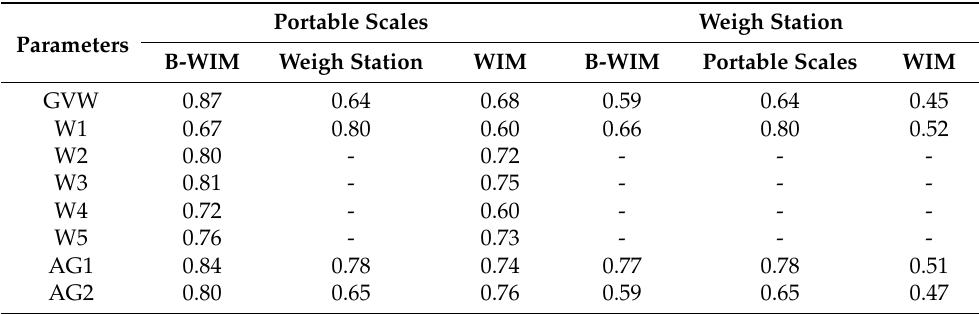
Table 7. Summary of the correlation coefficients calculated for portable scales and weigh station